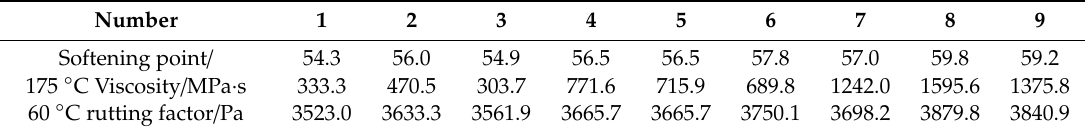
Table 4. Orthogonal test results of high temperature performance index of